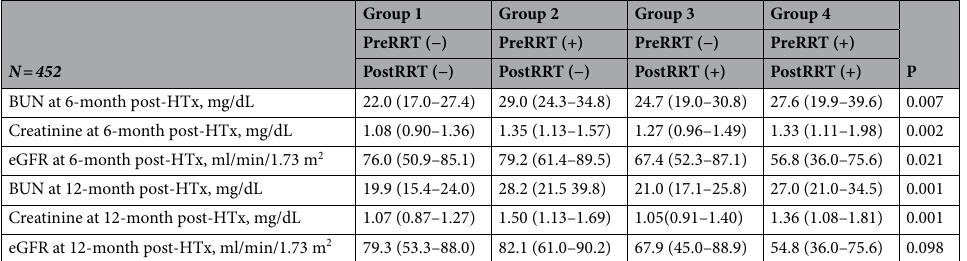
Table 2. Renal function after isolated HTx according to perioperative RRT support. Data were expressed as median (IQR). BUN blood urea nitrogen, eGFR estimated glomerular filtration rate. *Patient who were on the dialysis at 6 and 12 months were excluded (n =